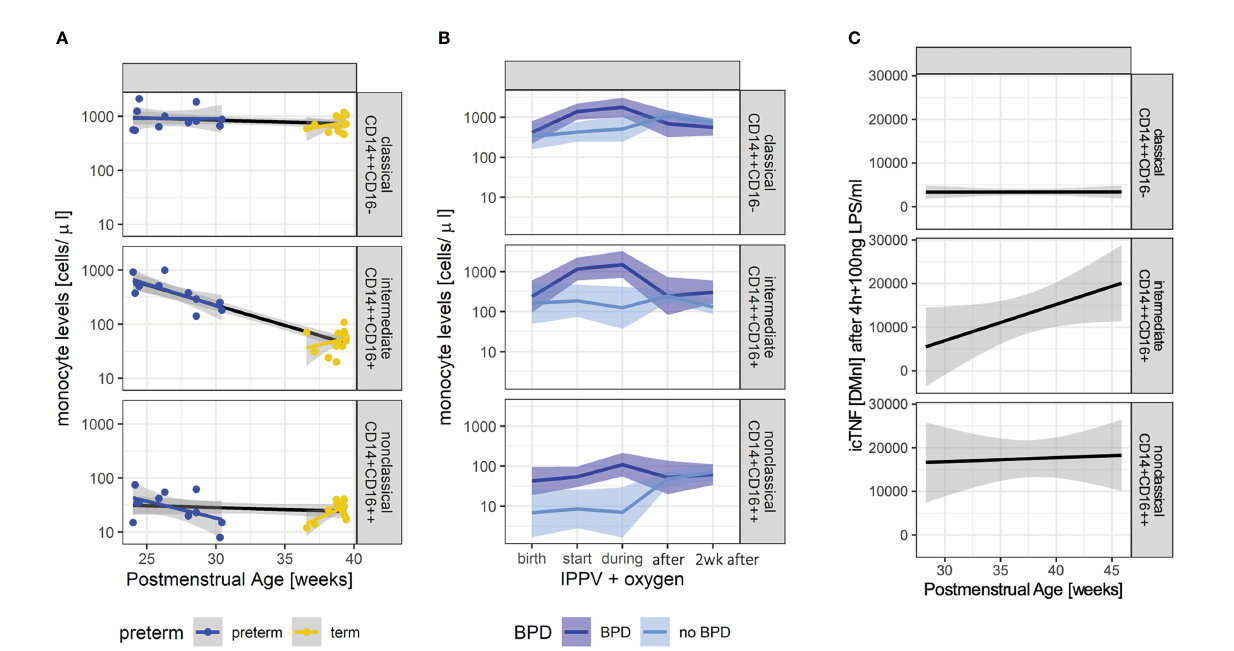
FIGURE 1 Characteristic monocyte subtypes at birth in infants developing BPD. (A) : Monocyte levels (upper panel: classical (CD14 ++ CD16 - ), middle panel: intermediate (CD14 ++ CD16 + ), lower panel: nonclassical CD14 + CD16 ++ ) of preterm (n=11, blue) and term (n=14, yellow) infants at the day of birth (+72h if not done immediately). Overall trend dependent on PMA indicated by black lines. Group comparisons: abundancy preterm vs. term 0.695, p-value=0.067; development with PMA (slope): -0.017, p-value= 0.003. (B) : Monocyte levels (upper panel: classical (CD14 ++ CD16 - ), middle panel: intermediate (CD14 ++ CD16 + ), lower panel: nonclassical CD14 + CD16 ++ ) in preterm infants with (n=15, dark blue) and without BPD (n=15, light blue) at birth up until 2 weeks after the start of invasive positive pressure ventilation (IPPV) and oxygen therapy. Linear mixed effect models take PMA into account. Levels of nonclassical monocytes are elevated at birth (pairwise comparison, p-value=0.004); nonclassical (BPD vs. no BPD p-value < 0.001), intermediate (BPD vs. no BPD p-value=0.011) and classical (BPD vs. no BPD p-value=0.004) differ during IPPV. (C) : Intracellular TNF a (icTNF) expression in response to LPS stimulation (4 hours after) in monocytes of preterm infants (n=9) (upper panel: classical (CD14 ++ CD16 - ), middle panel: intermediate (CD14 ++ CD16 + ), lower panel: nonclassical CD14 + CD16 ++ ). Increases in icTNF are statistically signi fi cant in intermediate (p-value = 0.005) and nonclassical monocytes (p-value = 0.033). Levels of icTNF are displayed as delta mean intensities